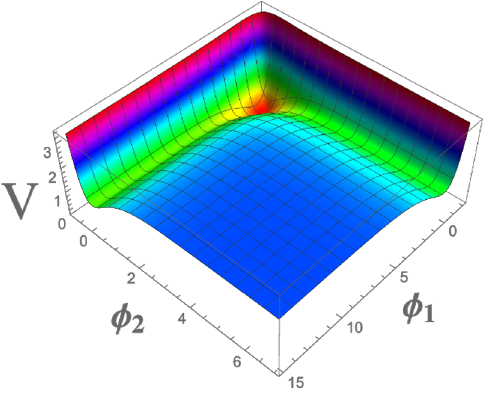
Figure 14 . The potential V infl of the E-model with two flat directions, φ 1 and φ 2 , with 3 α 1 = 6 and 3 α 2 = 1